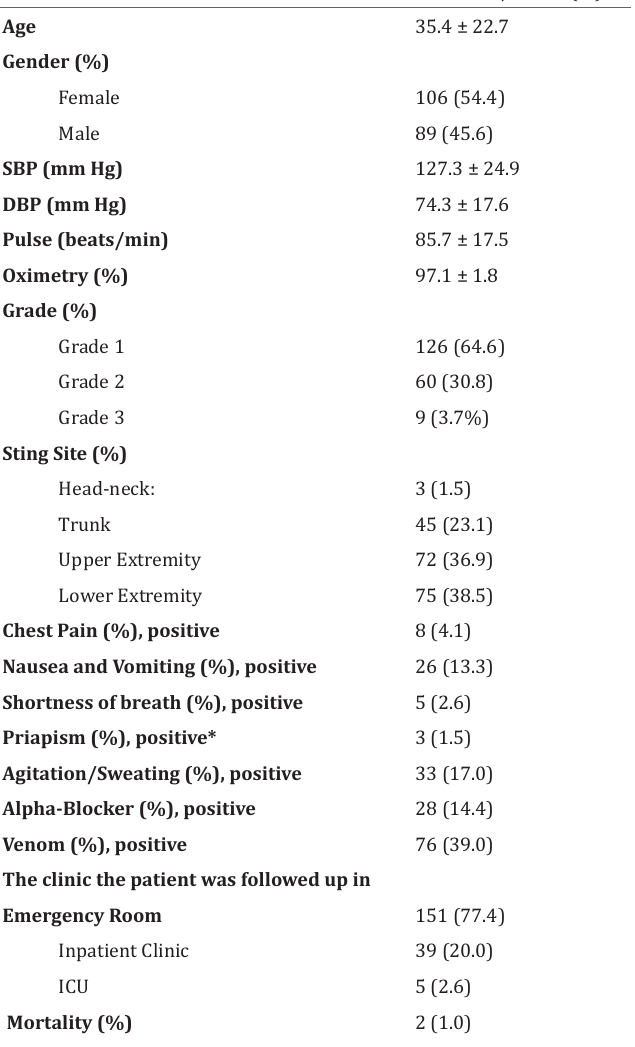
Some of the demographic and clinical characteristics of